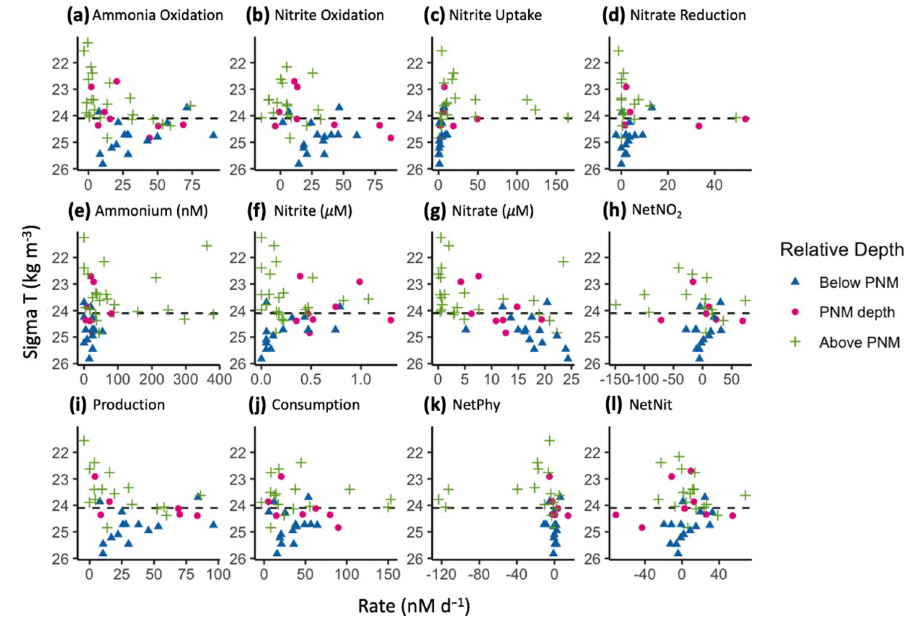
Figure 4. Aggregated rate measurements from 2016–2018 with respect to density ( (cid:54)T , kgm − 3 ): ammonia oxidation, nitrite oxidation, nitrite uptake and nitrate reduction ( a–d , respectively) (nMd − 1 ), ammonium (nM), nitrite and nitrate (µM), and net nitrite production (nMd − 1 ) ( e– h , respectively), and net production, net consumption, net nitrite production from phytoplankton and net nitrite production from nitrification (nMd − 1 ) ( i–l , respectively). Measurements are colored by relative depth to the station-specific depth of maximum nitrite: above the depth of maximum nitrite (green crosses), at the depth of maximum nitrite (magenta circles) or below the depth of the maximum nitrite (blue triangles). The mean isopycnal (24.1kgm − 3 ) for the ETNP nitrite maxima is marked as a horizontal dashed